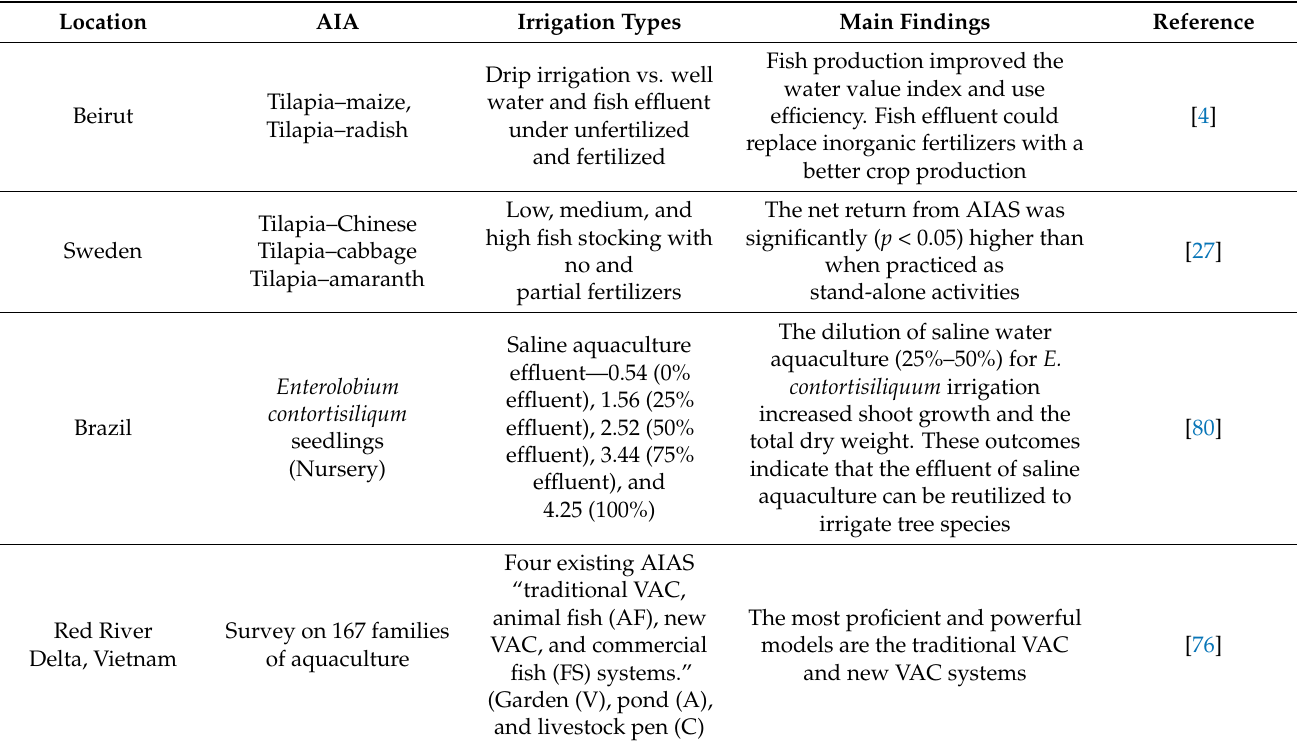
Table 8. International experience for pond-based